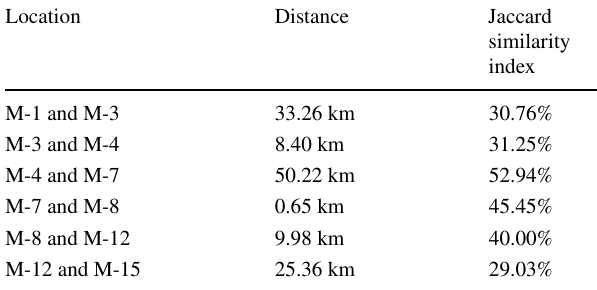
Table 9 Jaccard’s similarity index values at different locations of